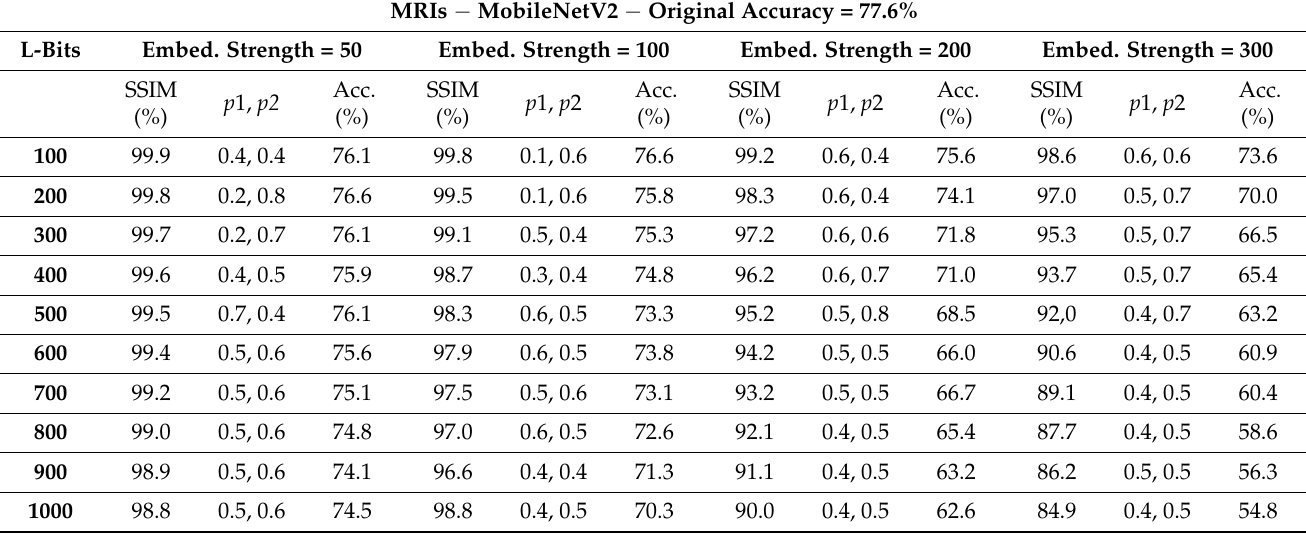
Table A1. KMsWA 2 attack on MobileNetV2 in MRIs.